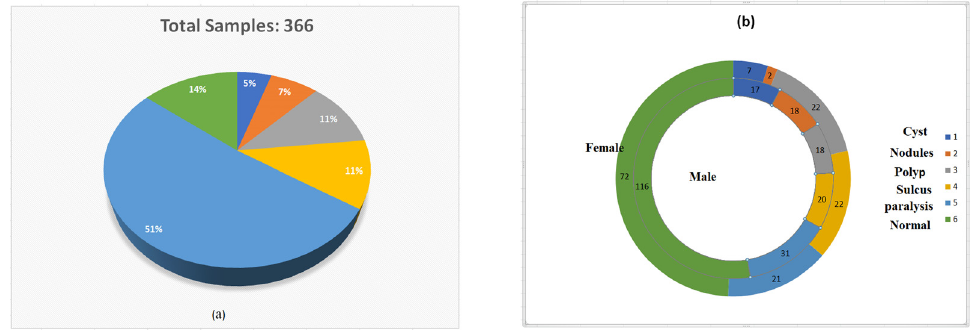
Figure 3: ( a ) AVPD distribution of healthy and voice - disordered people. ( b ) The number of male and female samples for each disease and normal subjects [ 21 ]